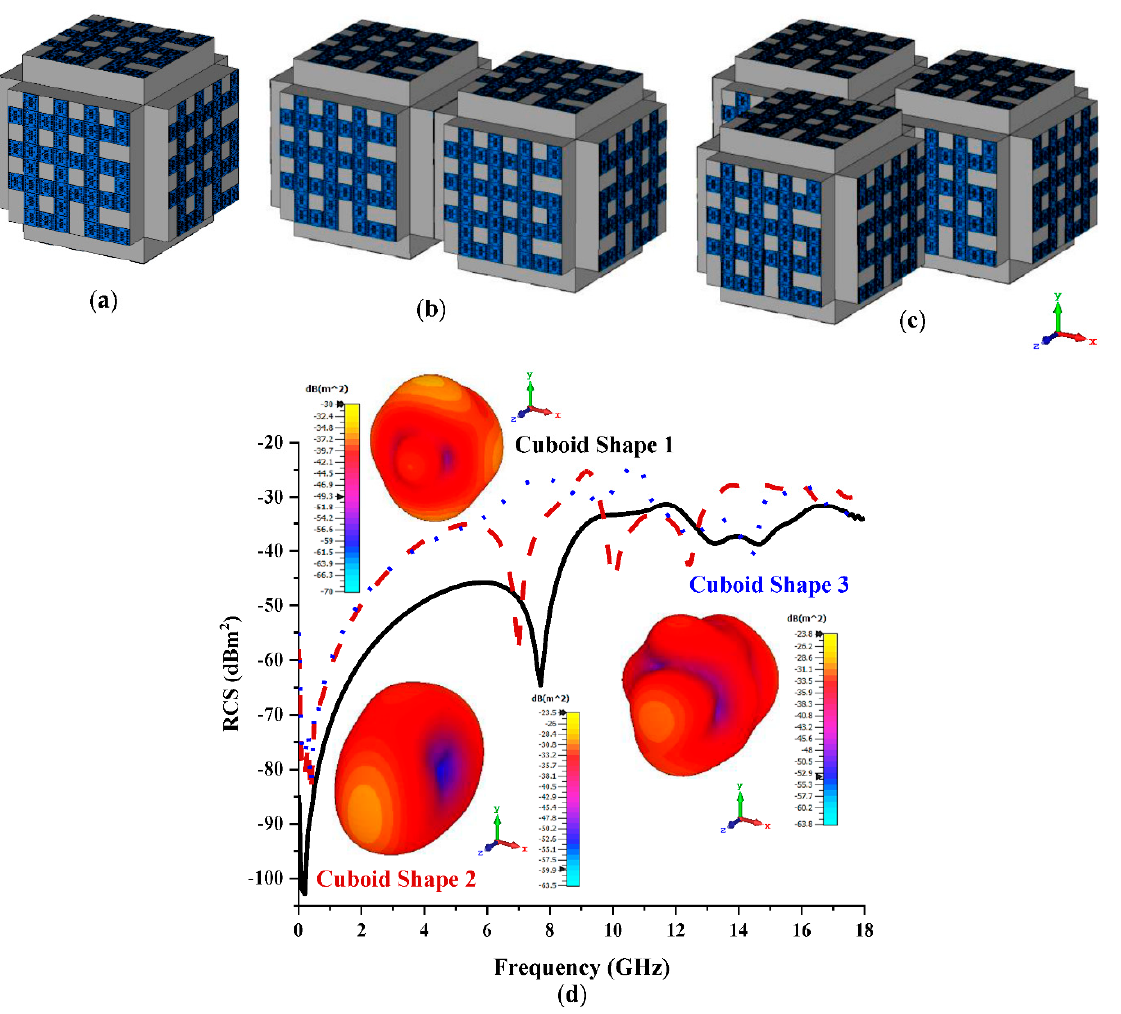
Figure 7. Eight lattices: ( a ) Cuboid Shape 1; ( b ) Cuboid Shape 2; ( c ) Coding Shape 3; ( d ) monostatic RCS and bistatic scattering pattern at 15 GHz.